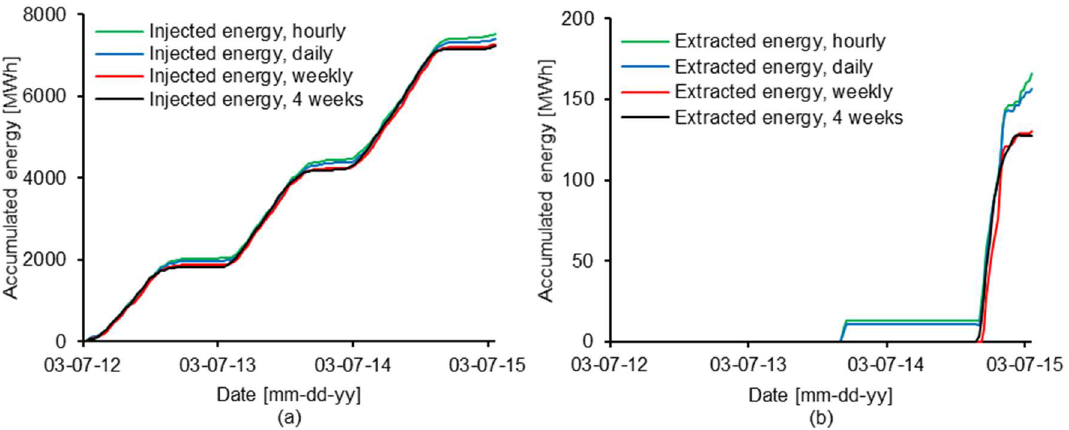
Figure 10. Calculated injected ( a ) and extracted ( b ) energy for different time steps.